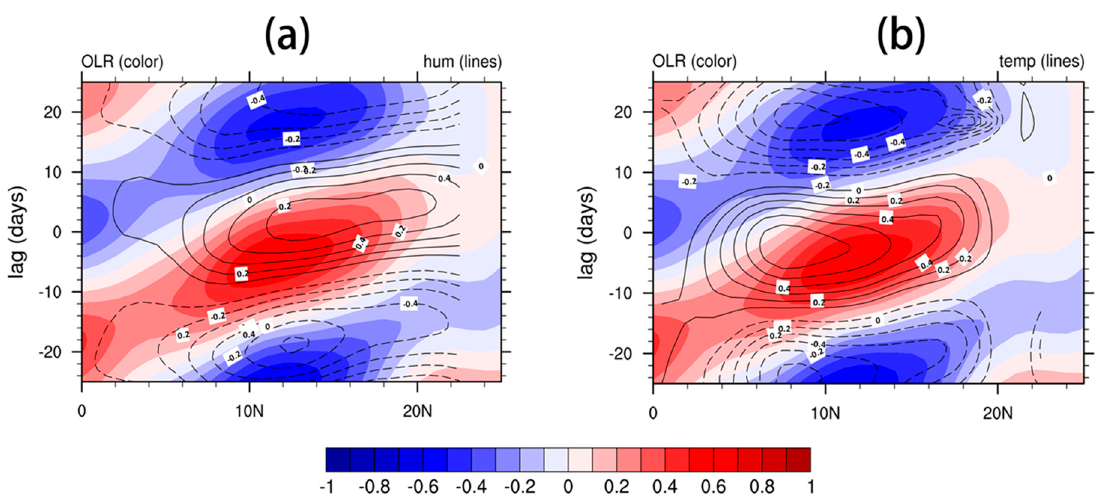
Figure 8. Latitude-based lead- / lag-time diagram of the composite raw pentad anomalies along the section of 110 ◦ E to 130 ◦ E for ( a ) outgoing longwave radiation (OLR, shaded) and air humidity (contour) and ( b ) OLR (shaded) and air-sea temperature (contour). The lead- / lag-time in days with positive (negative) values indicates the number of days after (before) day 0, equivalent to that shown in Figure 6.